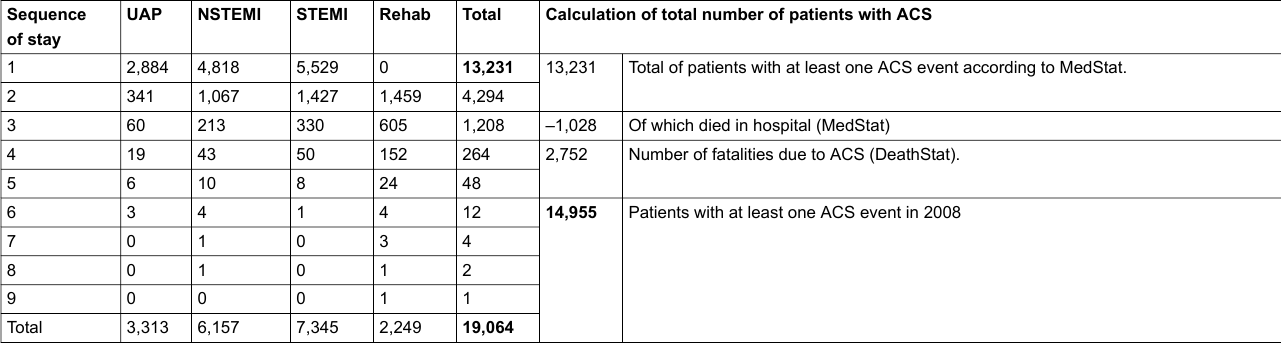
Table 1: Number of patients with ACS and number of inpatient stays due to ACS in 2008. Own calculation on MedStat [11] and DeathStat [12]. The table on the left shows all hospital and inpatient rehabilitation stays in 2008. Many patients experience multiple stays in the course of ACS treatment (e.g., transfer to other hospital or rehabilitation clinic). A total of 4,294 patients had, for example, 2 or more stays. No patient has a rehabilitation stay as first treatment, as inpatient rehabilitation stays due to ACS can only be identified if preceded by a hospital stay in the same year. The table on the right shows the calculation of the total number of patients with at least one inpatient treatment. The 1,028 patients deceased in hospital have to be subtracted in order to avoid double counting.